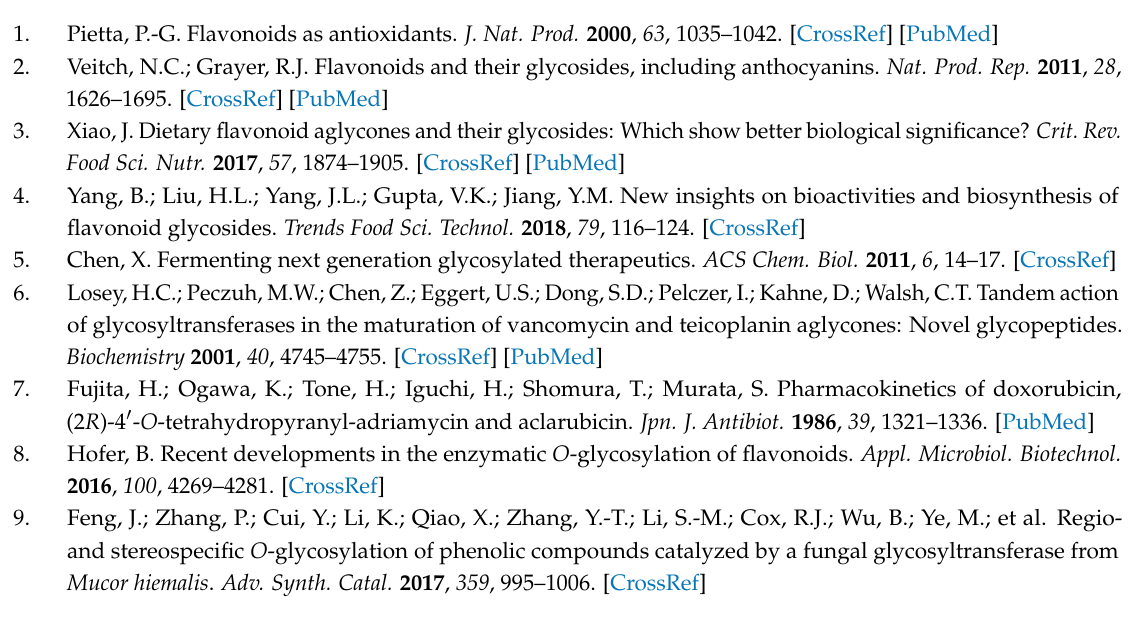
Table 1; ( − )-HRESIMS m / z 447.1289 [M − H] − (calcd. for C 22 H 23 O 10 , 447.1291). Table 1; ( − )-HRESIMS m / z 447.1294 [M − H] − (calcd. for C 22 H 23 O 10 , 447.1291). 5,7-Dihydroxyflavanone 4 (cid:48) - O - β - D -glucopyranoside ( 1c ): 1 H- and 13 C-NMR data see Table 1; ( − )-HRESIMS m / z 433.1122 [M − H] − (calcd. for C 21 H 21 O 10 , 433.1135). 5-Hydroxyflavanone 4 (cid:48) ,7-di- O - β - D -(4- O -methyl)glucopyranoside ( 1d ): 1 H- and 13 C-NMR data see Table 1; ( − )-HRESIMS m / z 623.1950 [M − H] − (calcd. for C 29 H 35 O 15 , 623.1976). 4 (cid:48) ,5,7-Trihydroxyflavone 3 (cid:48) - O - β - D -(4- O -methyl)glucopyranoside ( 2a ): 1 H- and 13 C-NMR data see Table 2; ( − )-HRESIMS m / z 461.1100 [M − H] − (calcd. for C 22 H 21 O 11 , 461.1084). 3 (cid:48) ,5,7-Trihydroxyflavone 4 (cid:48) - O - β - D -(4- O -methyl)glucopyranoside ( 2b ): 1 H- and 13 C-NMR data see Table 2; ( − )-HRESIMS m / z 461.1097 [M − H] − (calcd. for C 22 H 21 O 11 , 461.1084). 5,7-Dihydroxy-4 (cid:48) -methoxyflavone-3 (cid:48) - O - β - D -(4- O -methyl)glucopyranoside ( 3a ): 1 H- and 13 C-NMR data see Table 2; ( − )-HRESIMS m / z 475.1261 [M − H] − (calcd. for C 23 H 23 O 11 , 475.1240). 4 (cid:48) -methoxyisoflavone 7- O - β - D -(4- O -methyl)glucopyranoside ( 4a ): 1 H- and 13 C-NMR data see Table 2; ( − )-HRESIMS m / z 489.1422 [M − H] − (calcd. for C 24 H 25 O 11 ,